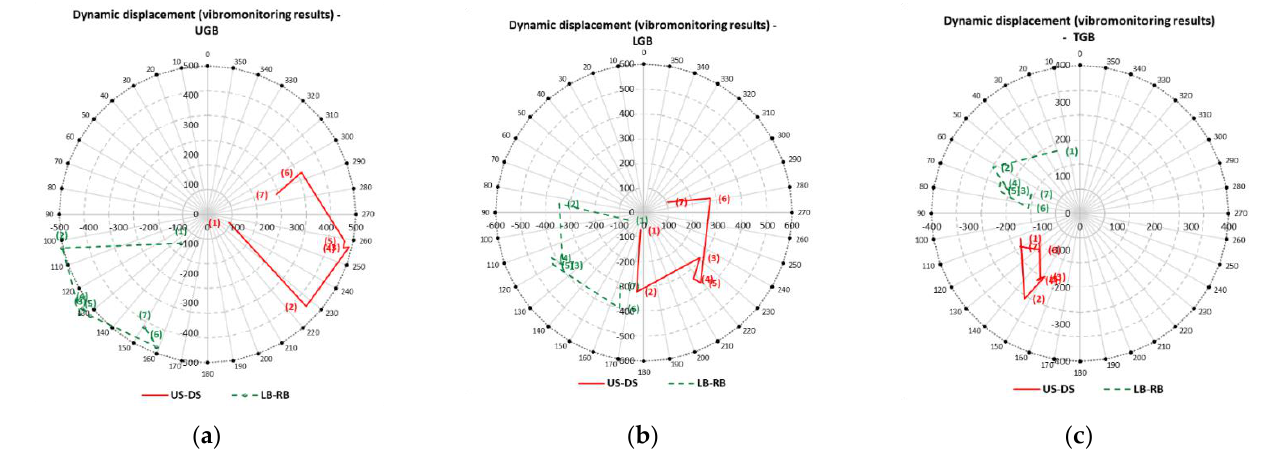
Figure 2. Vector diagrams of the dynamic shaft displacements near guide bearings ( μ m): ( a ) UGB — upper generator guide bearing; ( b ) LGB—lower generator guide bearing; ( c ) TGB—turbine (guide) bearing (the numbers (1) ÷ (7) correspond to mode numbers in Table 1; description of the modes is given in Section 3).